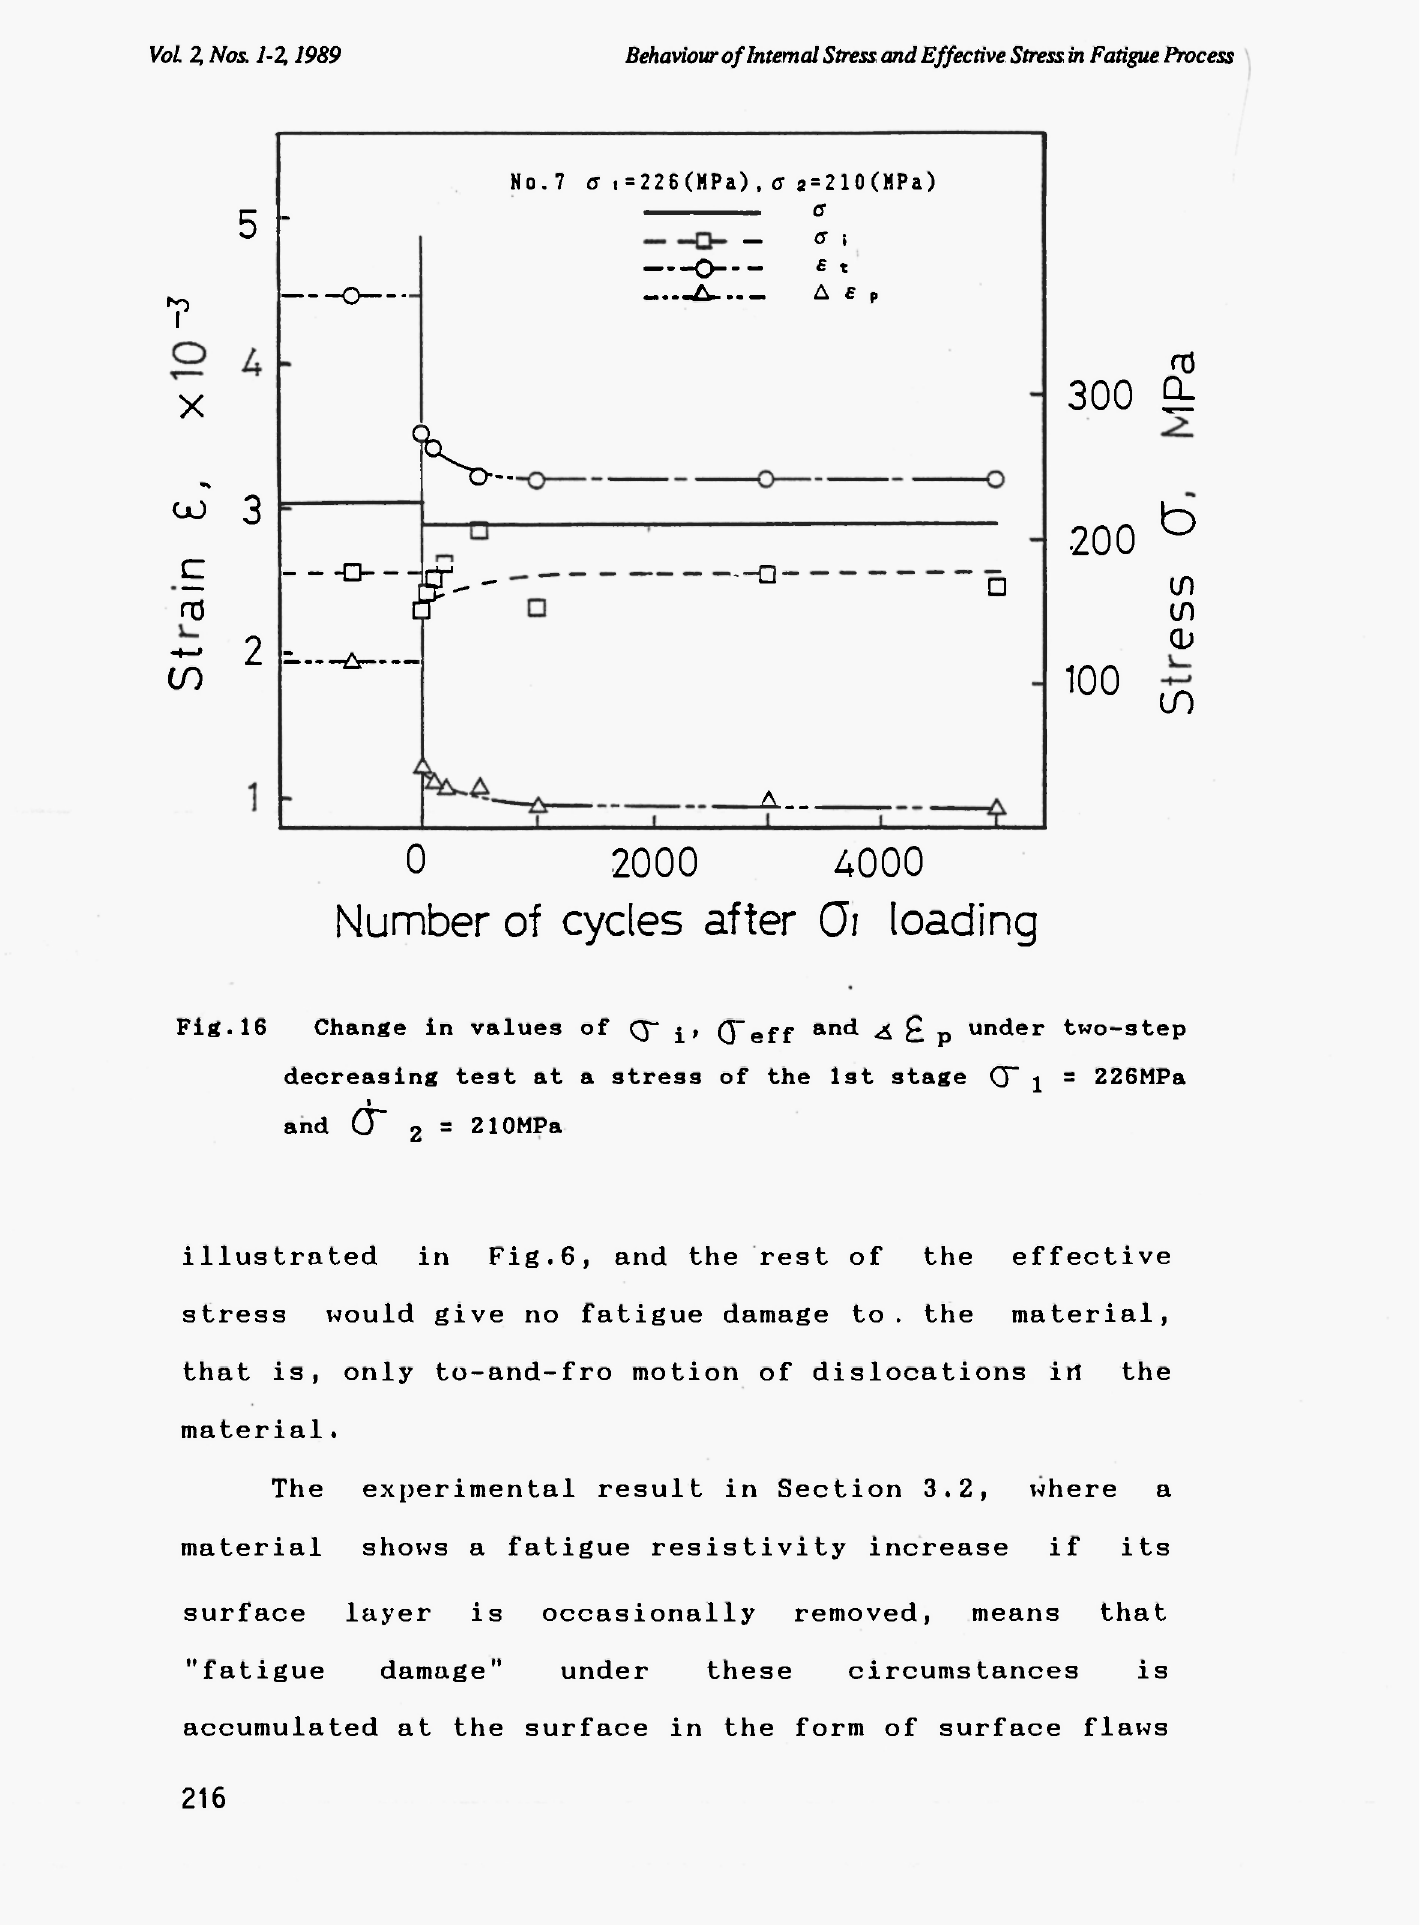
Fig. 16 Change in values of i» Q~eff an< * Λ £ ρ under two-step decreasing test at a stress of the 1st stage (J" j = 226MPa 1 and 0~ 2 =